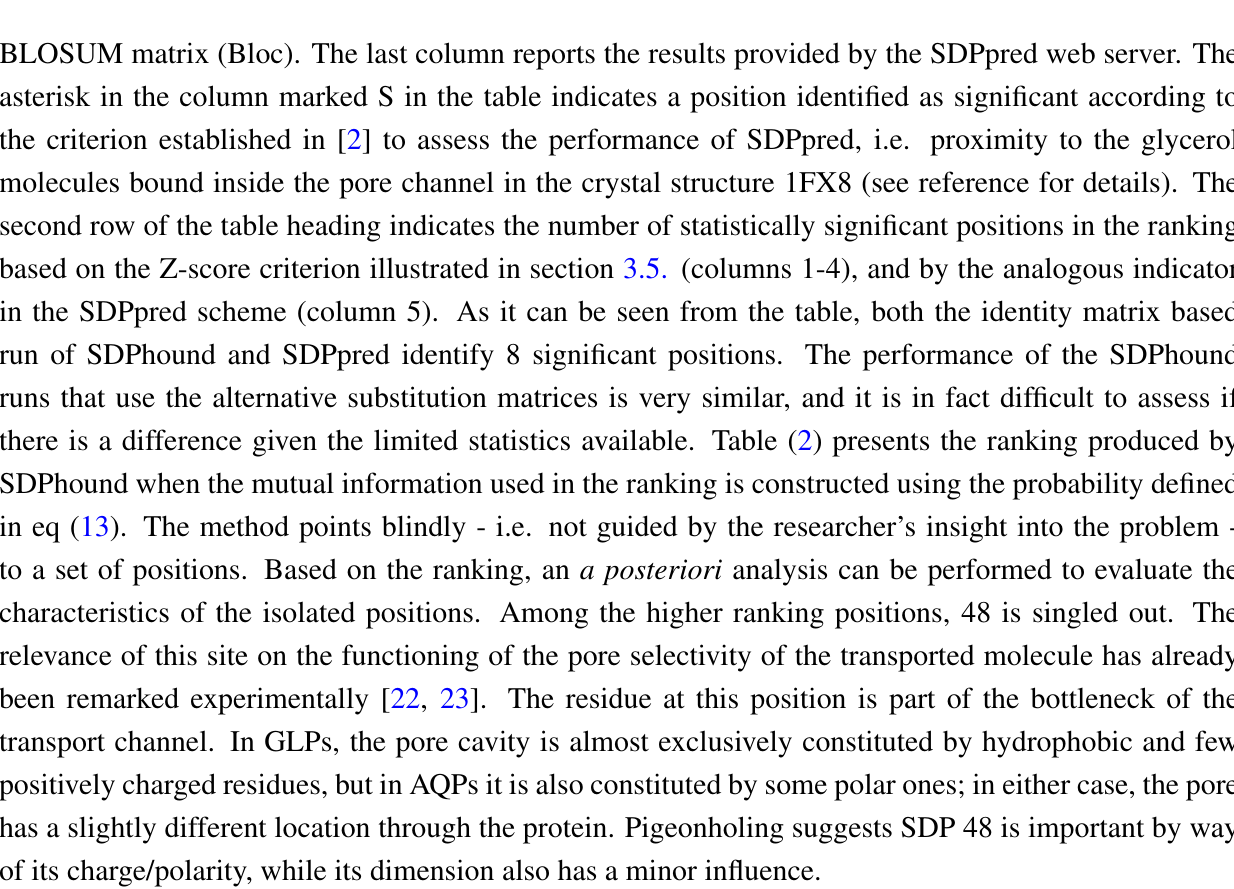
Table 2. Substitution class based runs over SDPs relevant to aquaporins and the glycerol- uptake facilitators distinction. For each position, the ranking in the run related to hydropho- bicity (hyd), charge (crg), and size is shown. “ − ” means that in that run, the position ranked below 40 th . A color code is used to help reading: the positions are colored according to which “quality” (hydrophobicity=red, charge/polarity=green or size=blue) is more relevant to that position. In ambiguous cases “intermediate” colors are used: magenta=blue+red (hyd+size), yellow=red+green (hyd+crg) and cyan=green+blue (crg+size). For practical